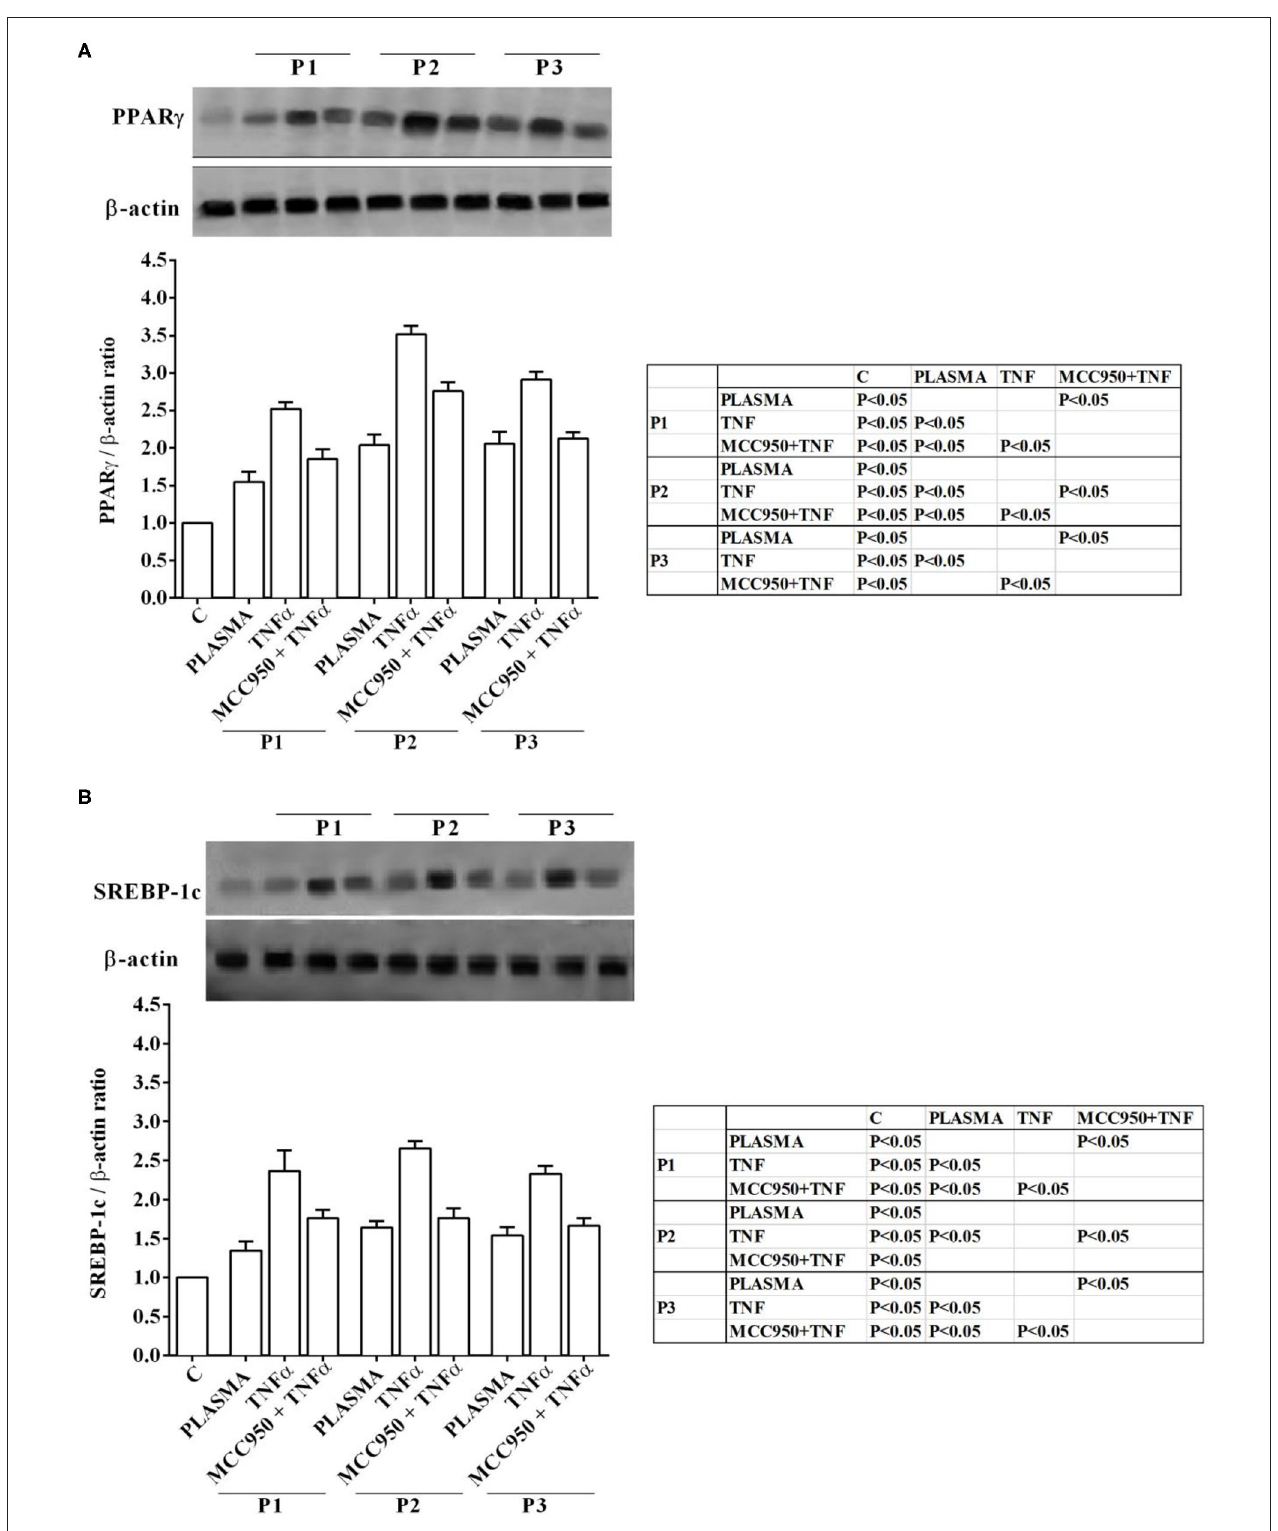
FIGURE 4 | Effects of NAFLD plasma on PPAR γ (A) and SREBP-1c (B) expression in Huh7.5 cells. P, patient; M, MCC950 (1nM, for 30min). Other abbreviations are as described in previous Figures. In the densitometric analysis, all values are normalized vs. control which is normalized, as well, and considered as 1. They are shown as fold changes vs. control. Reported data are means ± SD of five independent experiments for each experimental protocol.